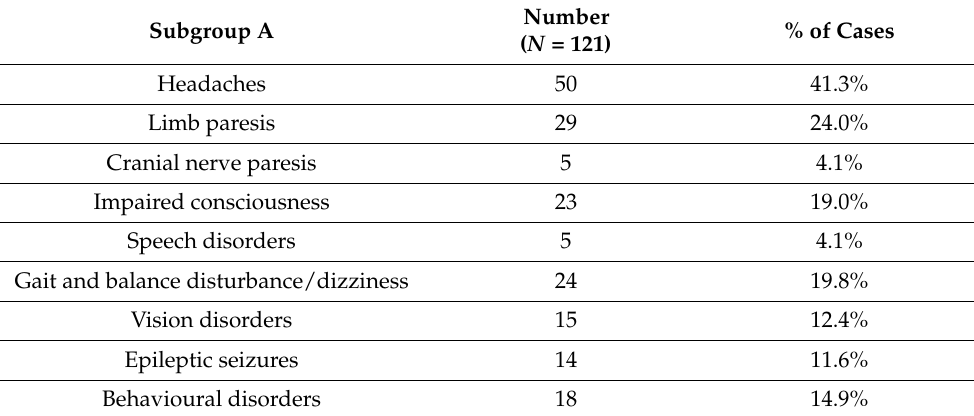
Table 1. Neurological symptoms in the group of patients with neurological disorders (subgroup